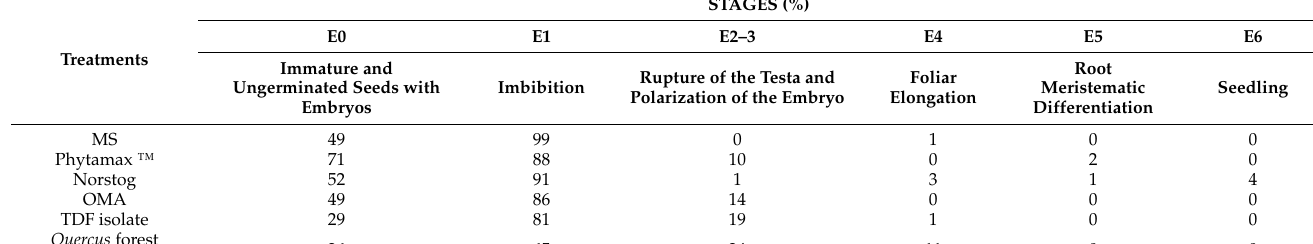
Table 2. Asymbiotic (1–4 treatments) and symbiotic (5–6 treatments) germination and development of Cypripedium irapeanum seeds after 256 days of sowing. MS = Murashige and Skoog [73], Modified